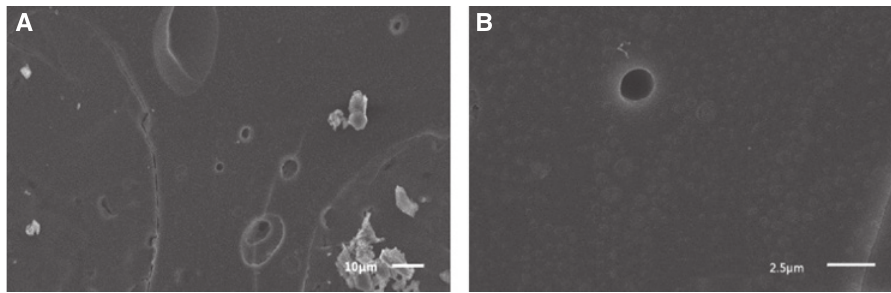
Figure 11: Surface morphology of C900 taken at different magnifications (A) × 1000 and (B) × 5000.